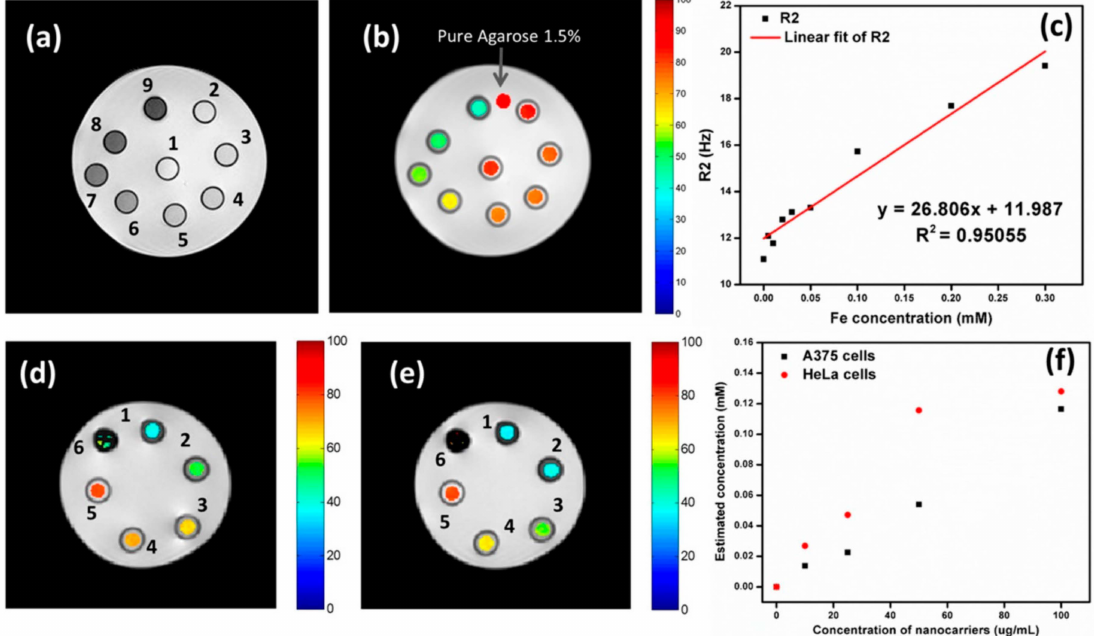
Figure 11. MRI ( a ) with a T2 weighting and ( b ) with a T2 map (ms) superimposed in color. MFCSNPs- FA-CHI-5FU nanocarrier concentrations are shown in part as numbers (1–9) that correspond to areas representing miniature phantom tubes. ( c ) Different concentrations of MFCSNPs in agarose (1.5%) were used to create phantoms, as detailed in the Experimental section. Fe concentration against R2 plot for MFCSNPs-FA-CHI-5FU nanocarriers (red line represents a linear fitting). MRI scans with color overlays of ( d ) A375 and ( e ) HeLa cells. Small phantom tubes containing A375 and HeLa cells were treated with varying quantities of MFCSNPs-FA-CHI-5FU nanocarriers (0–200 g/mL), as shown by the numbers (0 refers to cells only and 2–6 correspond to various concentrations of nanocarriers (0–200 g/mL)). ( f ) A concentration vs. relaxivity plot of nanocarriers incubated with cancer cells, with the y-axis representing the estimated concentration of internalized